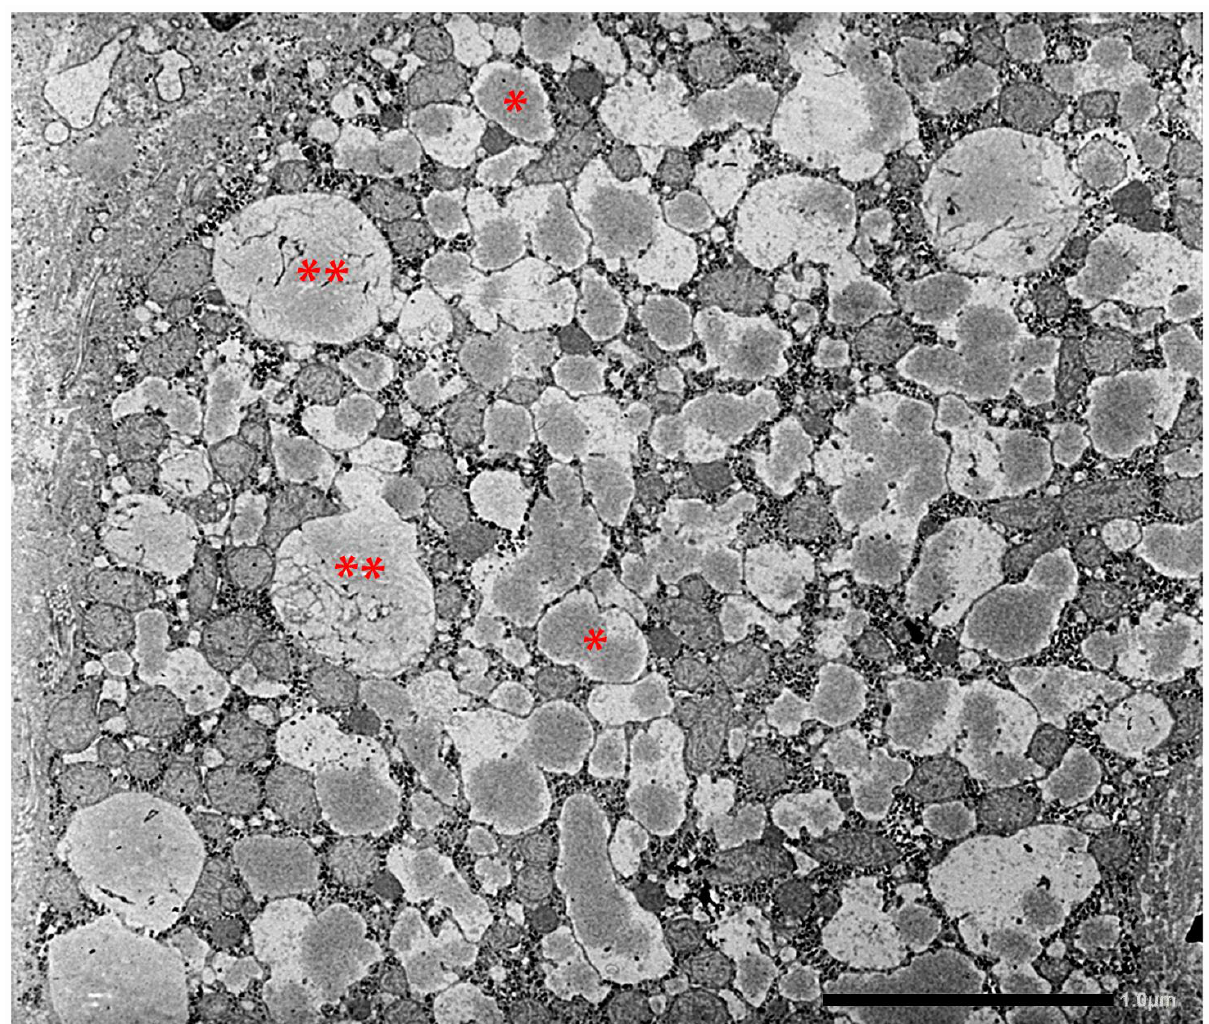
Figure 15. The EM-photograph from a Pi ZZ liver shows a hepatocyte whose ER cisternae are plenty of AAT-like material. AAT appears as amorphous fluffy material detached from the limiting membranes (*), or as a compact, dense material associated with disrupted ER membranes (**) (EM × 12.000). Figure obtained from Callea F. PhD Thesis. Acco, Leuven 1983: 1–153.